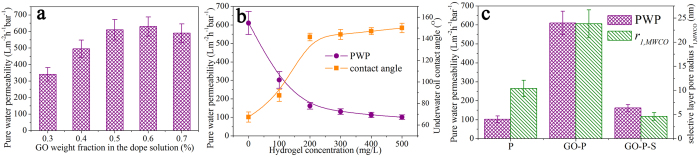
The pure water permeability and neutral solute selectivity of membrane.(a) The effect of GO weight fraction in nanocomposite dope solution on pure water permeability (PWP) of GO-P membrane. (b) The effect of hydrogel concentration on PWP and underwater oil contact angle of GO-P-S membrane. (c) Membrane PWP and selective layer pore radius (r1, MWCO, which is calculated from MWCO).